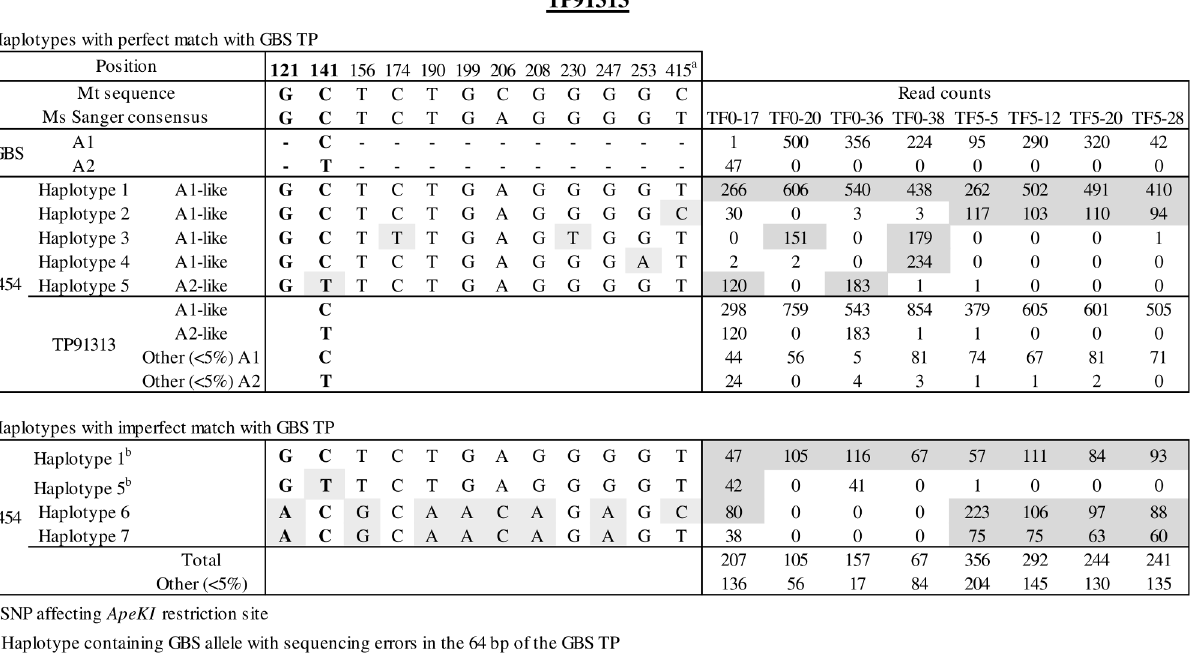
Fig 3. Haplotypes identified with 454 sequences covering TP91313 in eight plant samples. Haplotypes defined with 454 sequences with perfect and imperfect match with GBS 64bp sequence are listed separately. Position of SNPs is based on location on M . truncatula reference sequence. SNPs included in UNEAK TP are highlighted in bold. RC of GBS alleles (A1 and A2) and 454 sequences covering each haplotype in the eight genotyped plant samples are indicated. Cumulative number of A1 like and A2 like reads are also presented. SNPs with RC (cid:1) 5% in individual plant samples were used to define haplotypes. Haplotypes with frequency < 5% in all individual plant samples are not indicated but total read counts supporting those other haplotypes are reported. Haplotypes corresponding to each of the 14 GBS loci are presented in S3 Table. doi:10.1371/journal.pone.0131918.g003 counts of SNP loci determined with the two sequencing methods, as illustrated for TP61949 in Fig 4. Genotypes calls obtained with both approaches were either concordant or discordant. Half of the genotypes called based on a tetraploid allelic ratio obtained with GBS and 454 sequencing concurred (Table 6). Of these concordant calls, 80% were homozygous (4|0 and 0| 4) and 20% were heterozygous (3|1, 2|2 or 1|3). Discordant tetraploid allelic ratios were on